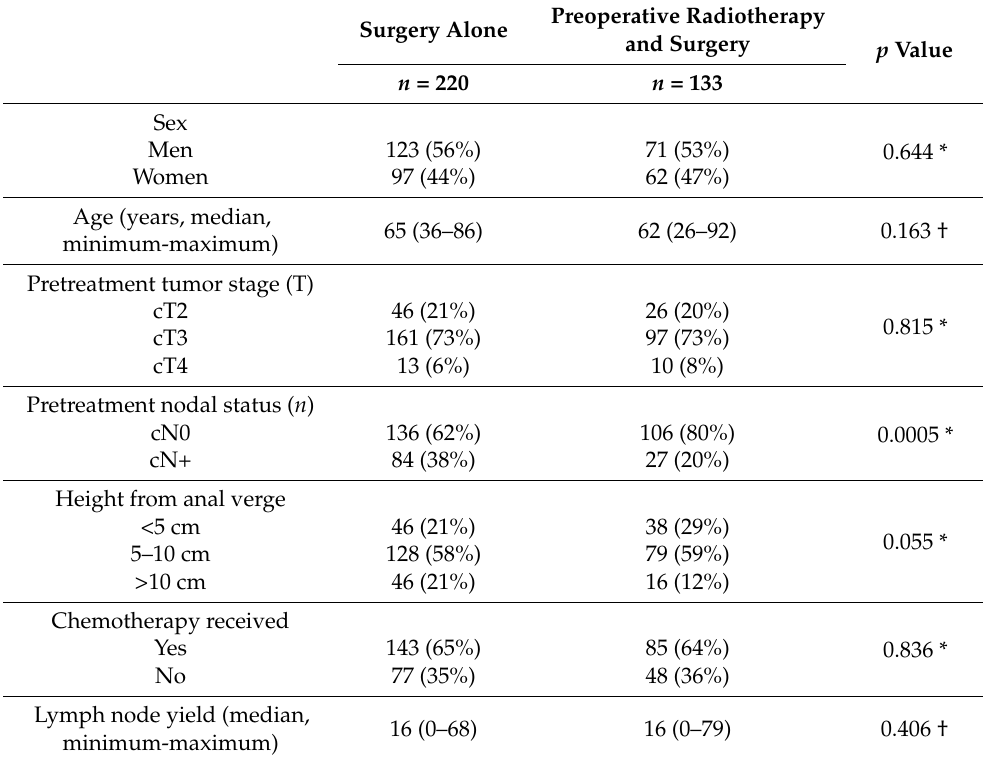
Table 1. Patient clinical and demographic characteristics, by treatment group before propensity-score matching (R0 patients).